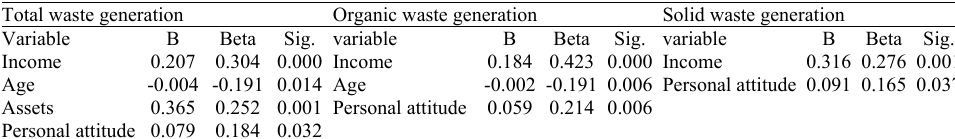
Table 6: Results of multiple regression analysis